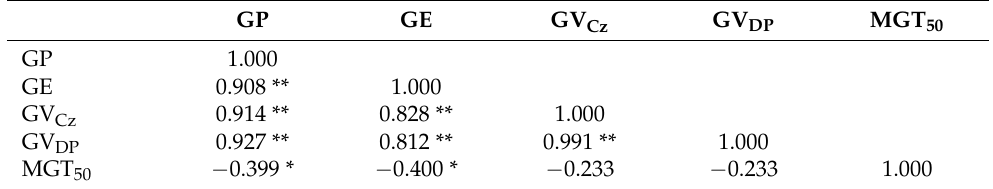
Table 3. Linear correlation coefficient (r, Pearson) between the germination parameters. Sample size: N =